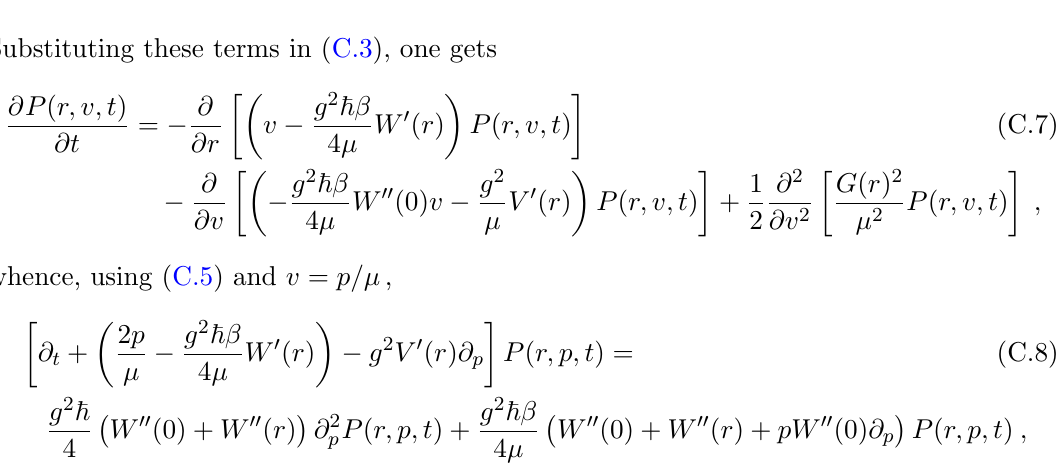
= 0 : 08 fm and l = 0 : 194 fm, where l = 0 1